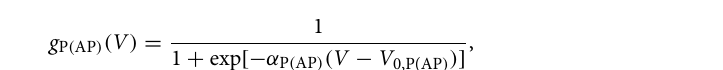
Figure 1. Modeling of TMC. ( a ) Debye-Fröhlich (DF) model incorporating Zhang-sigmoid model, parabolic barrier approximation (PBA), and spin-dependent drift–diffusion (SDD) model. ( b ) Equivalent circuit model of MTJs. ( c ) Sigmoid